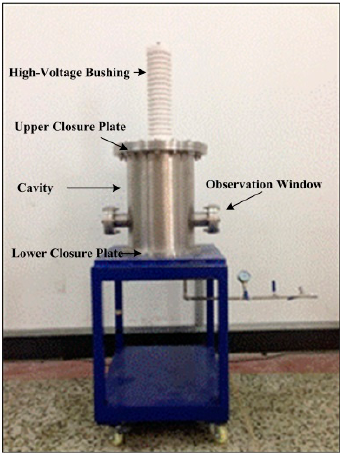
Figure 2. Photograph of discharge device. 96